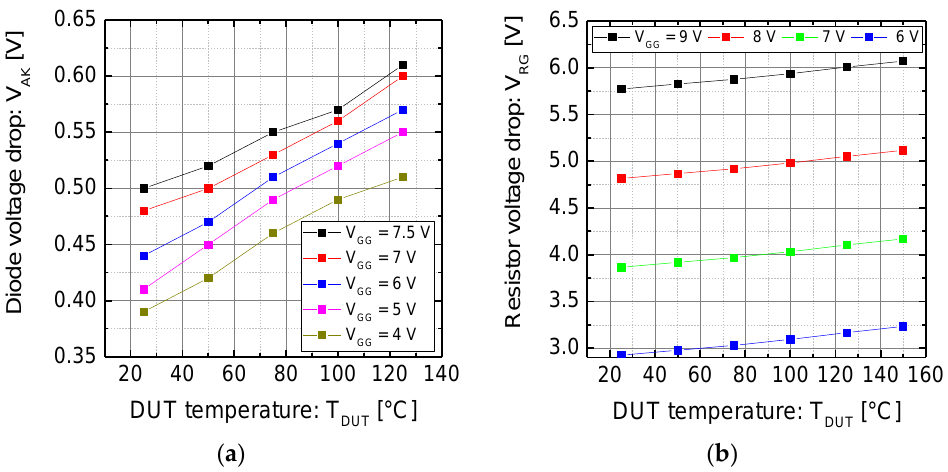
Figure 6. Voltage drop ( a ) on the diode as a function of the temperature on the DUT_S and ( b ) on the series resistor as a function of the temperature on the DUT_O. The data were measured at different values of gate supply voltage.